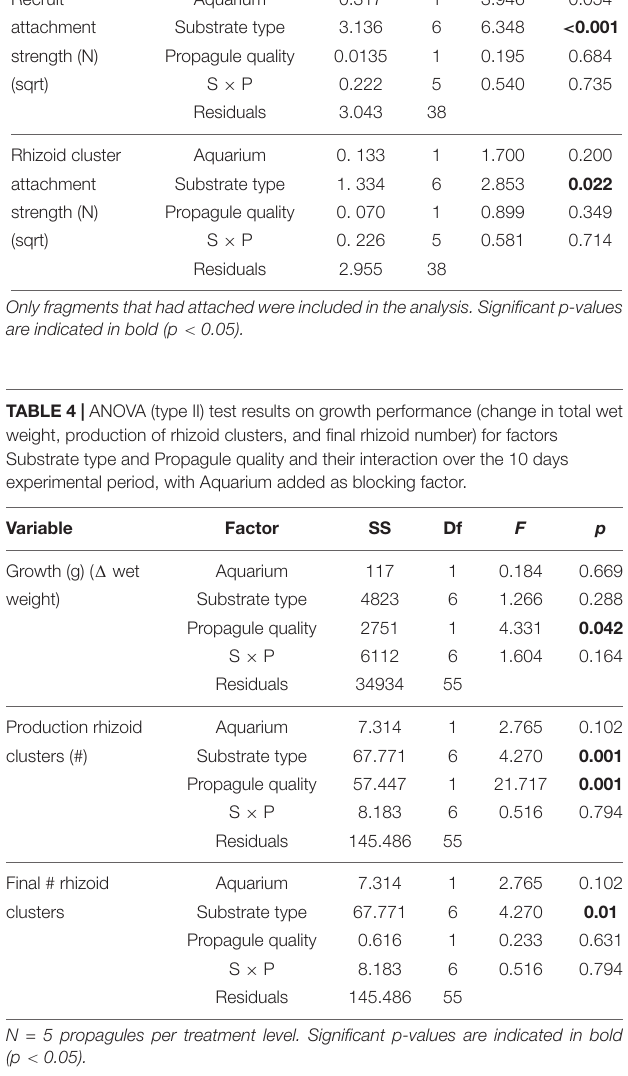
FIGURE 5 | Attachment speed (days to attach) (A) , attachment strength (N) of entire fragment (B) and average attachment strength (N) per rhizoid cluster (C) , averaged over levels of Propagule quality. Only fragments that had attached within 10 days of experimentation were included in the analysis. N = 10, 2, 7, 4, 10, 10, 10 for habitats Sand, Artificial Rock, R, R – T, Artificial Turf, R + T – S and R + T + S respectively. Letters indicate differences according to post hoc comparison ( p < 0.05). No post hoc comparison is available for the Artificial Rock treatment, as only two fragments had attached at the end of the 10 days experimental period. R, rock; T, turf; S, sediment. Error bars represent SE.